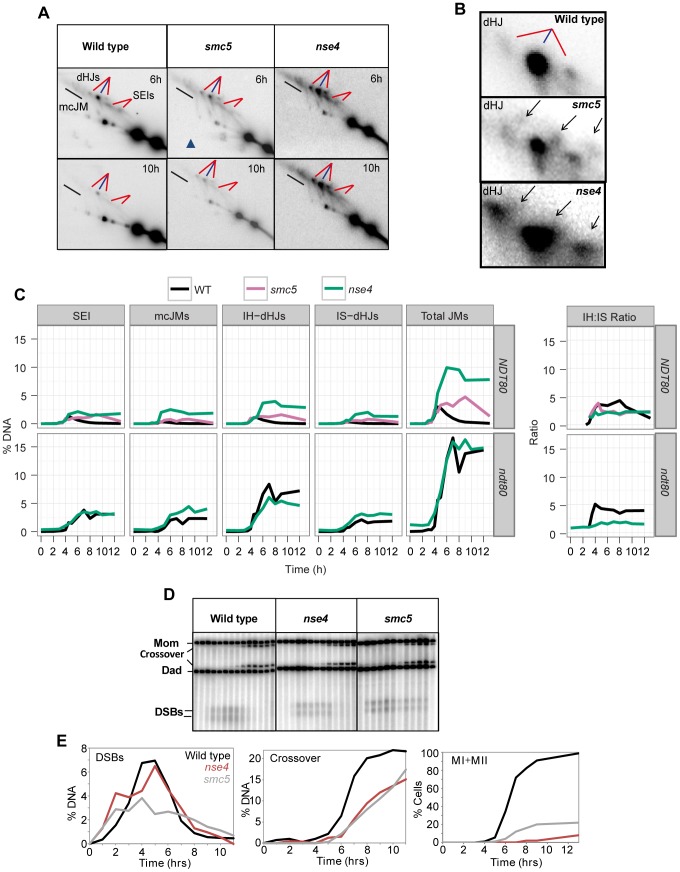
Aberrant joint molecules accumulate in smc5 and nse4 mutants.(A) Examples of time courses from 2D gels. Blue lines point at joint molecules formed between homologous chromosomes (interhomolog, IH) and red lines indicate joint molecules composed of sister chromatids (intersister, IS). Strains: WT (Y2976), smc5 (Y1211), nse4 (Y1212). (B) Enlarged dHJ spots from wild type, smc5, and nse4. (C) Smoothed levels of single end invasions (SEIs), multichromatid joint molecules (mcJMs), interhomolog-double Holliday Junctions (IH-dHJs), intersister-double Holliday Junctions (IS-dHJs), IH-dHJ to IS-dHJ (IH∶IS) ratio, and total joint molecules (Total JMs). Cumulative levels of recombination were assessed in the ndt80Δ background (lower panel). Strains: ndt80 (Y3025), ndt80 nse4 (Y3843). (D) Examples of time course analyses of double-strand break and crossover formation. (E) Quantification of DSB, crossover, MI+MII nuclear divisions.